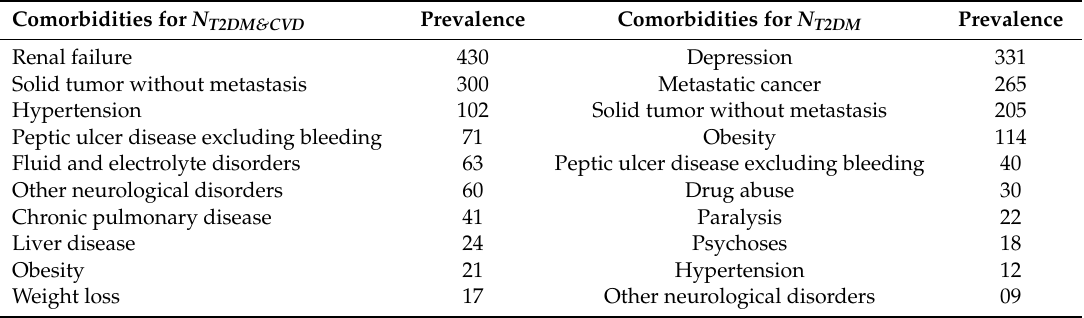
Table 5. Top 10 most prevalent comorbidities for patients with both T2DM and CVD, and patients with only T2DM. The prevalence refers to the number of admissions that have ICD codes related to those comorbidities.